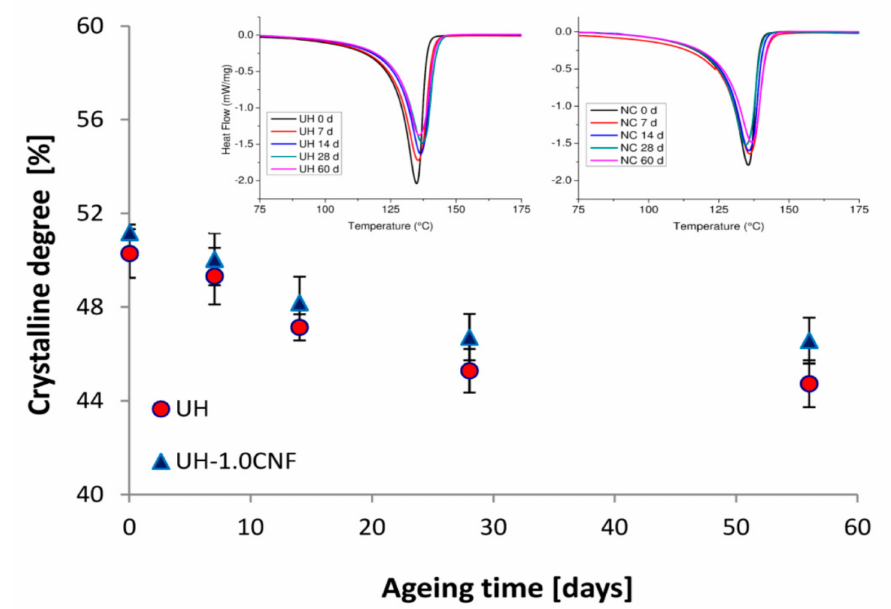
Figure 6. Crystalline degree in SSF of UH and UH-1.0CNF samples during the 60 days of ageing time with the DSC peaks in the